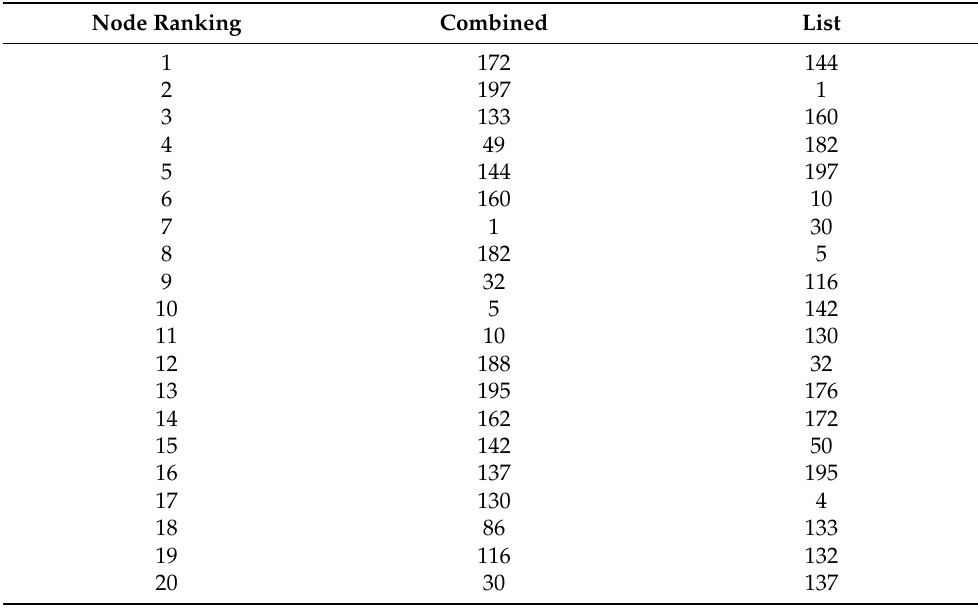
Table 3. Comparison between node ranking in both